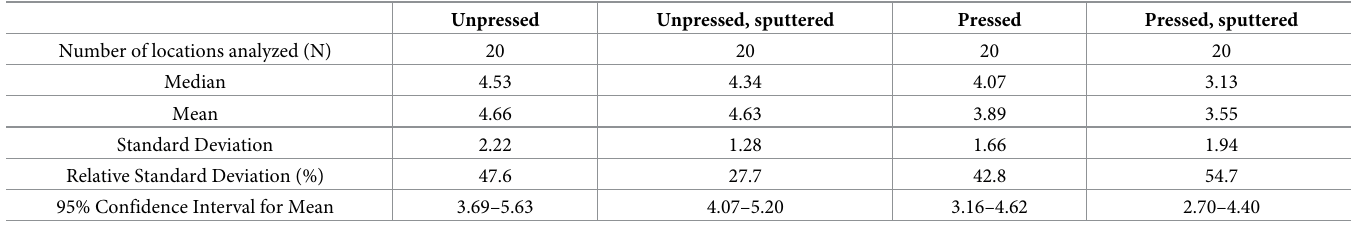
Table 1. Statistical summary of 35 Cl - /C 4 H3- secondary ion ratios for Olyset net as-received (unpressed), and pressed, with and without subsequent